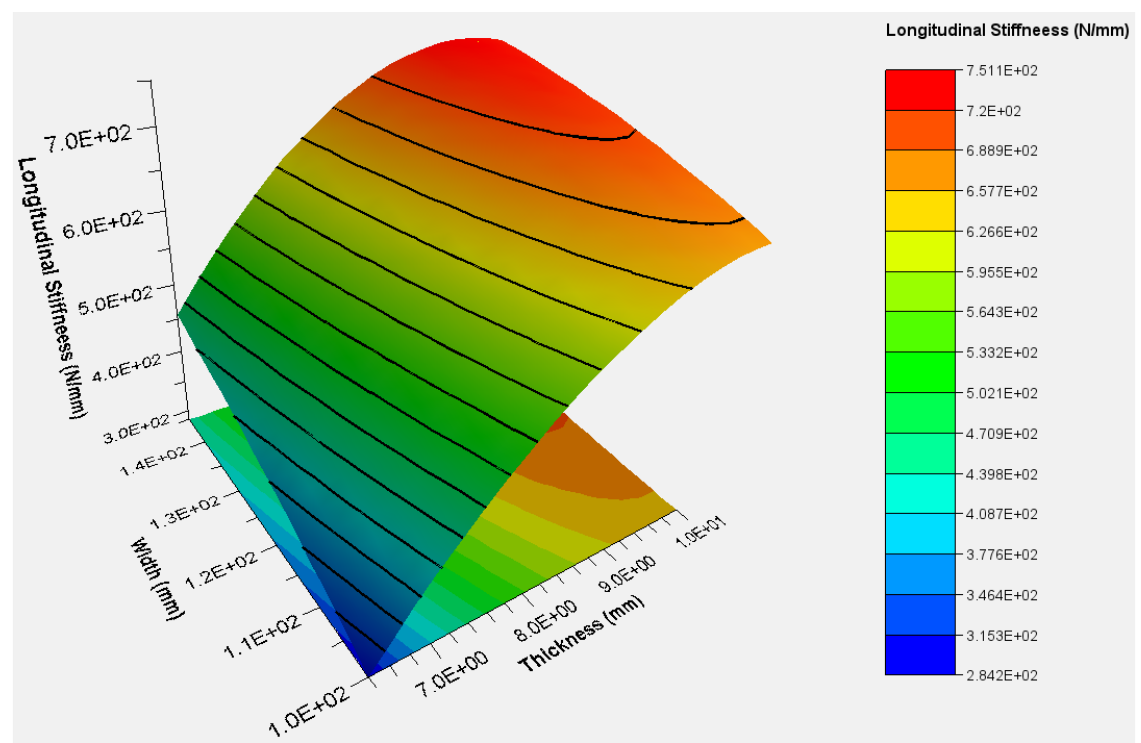
Figure 17. RSM for the longitudinal stiffness of the NPT as functions of the thickness and width of spokes.